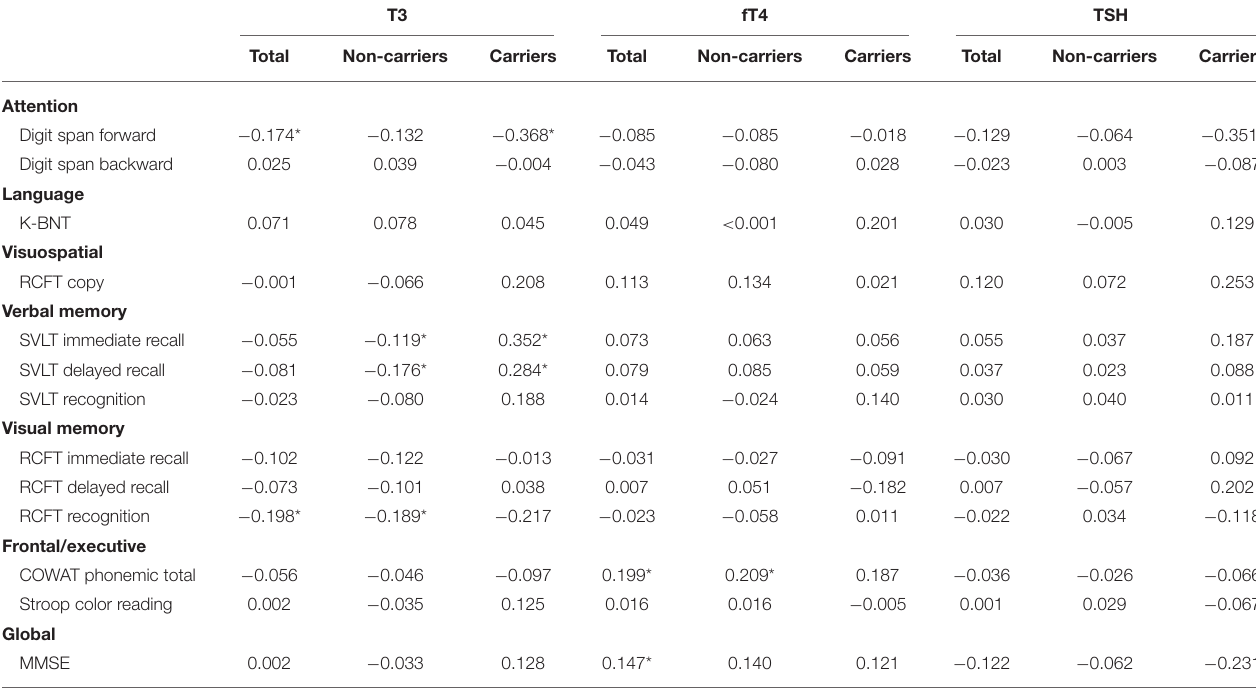
TABLE 4 | Correlation coefficient (r) between neuropsychological performance and thyroid hormone levels as well as TSH according to APOE ε 4